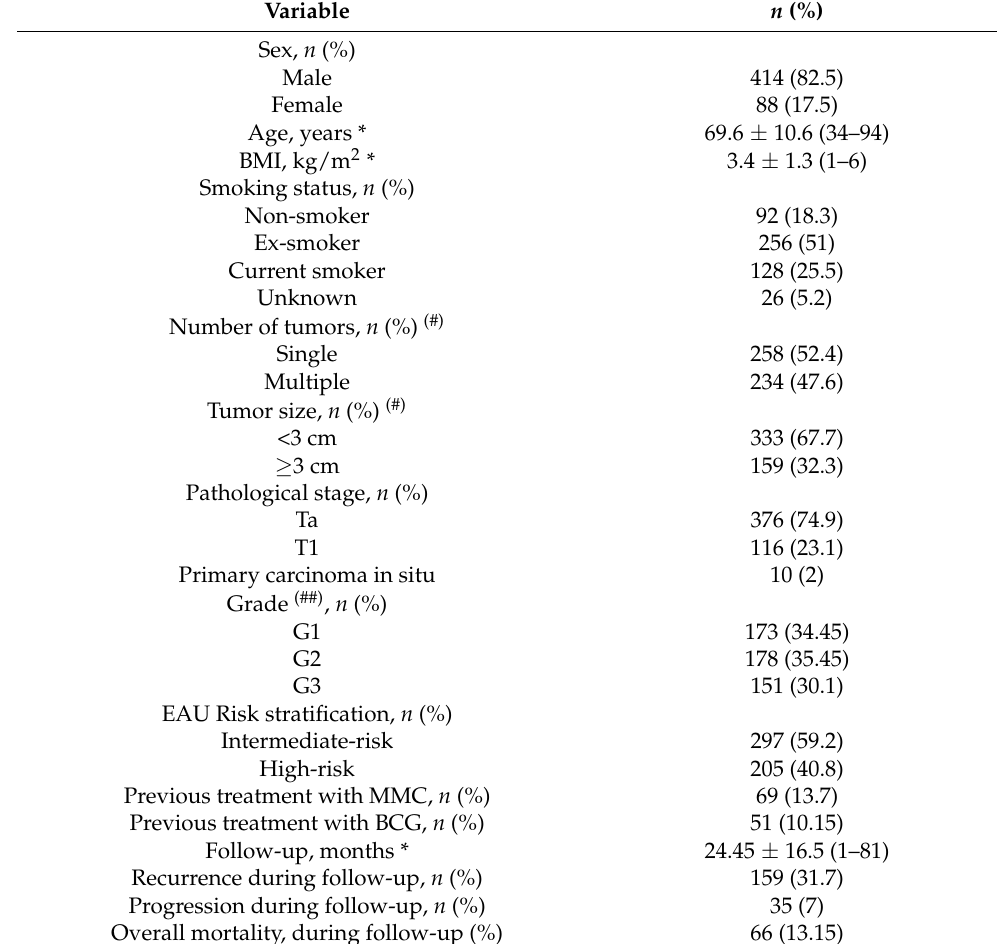
Table 1. Clinico-pathological characteristics of patients, FAS population ( n =